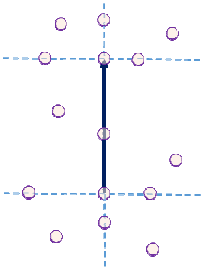
Figure 3. 15 Qualitatively Different Relations of a Point and a